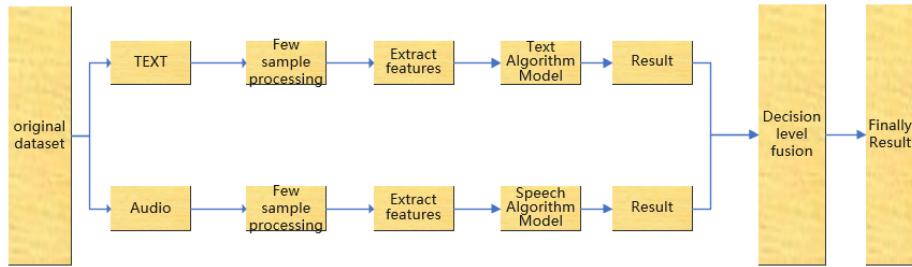
Figure 2. Decision Level Fusion Approach for Few